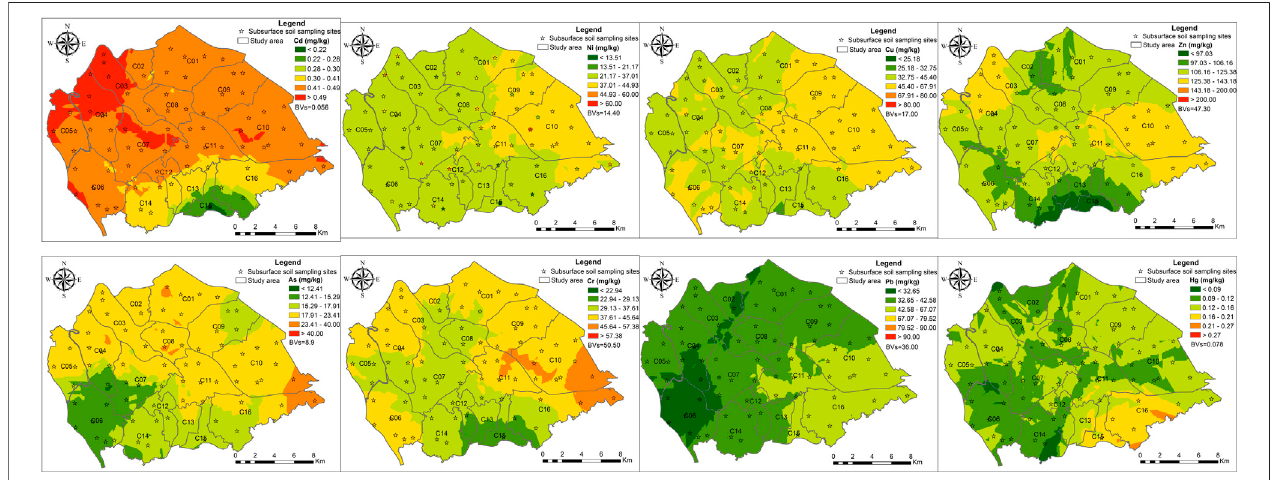
FIGURE 3 | Spatial distribution of heavy metal concentrations in subsurface